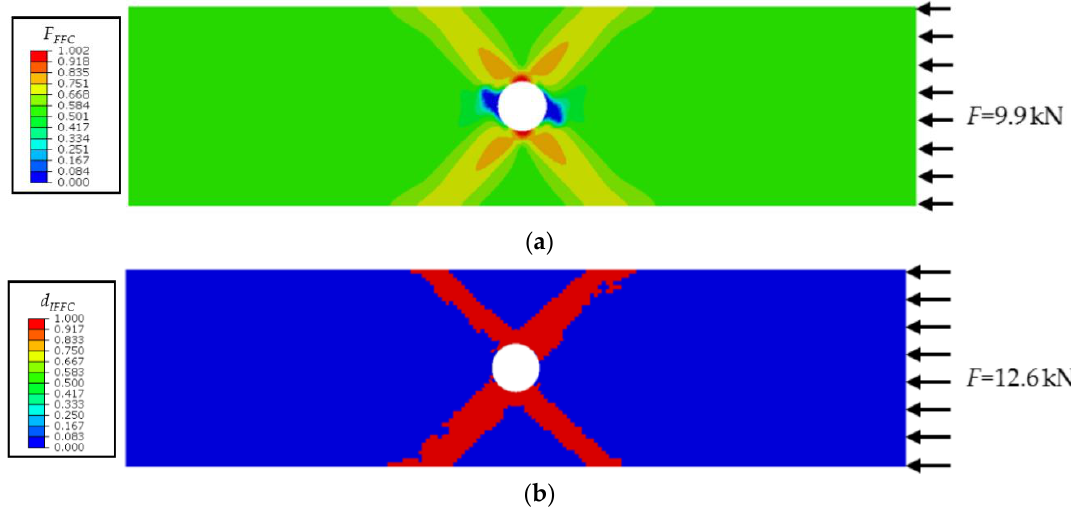
Figure 12. Experimental and numerically predicted F – ∆ curves